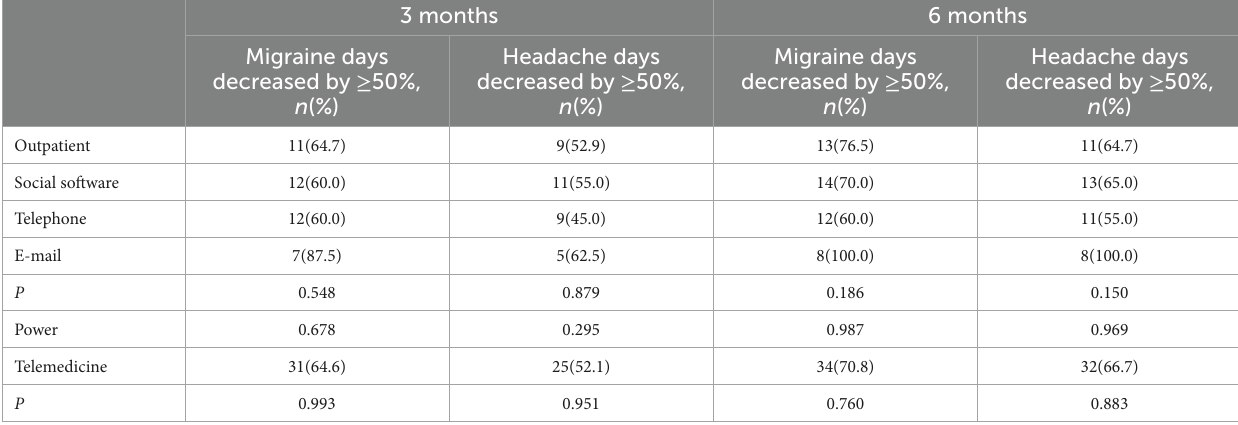
TABLE 2 Proportion of monthly headache days and migraine days decreased by ≥ 50% after follow-up.